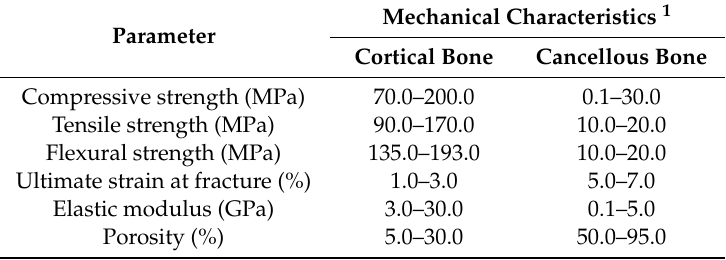
Table 1. Mechanical properties of human